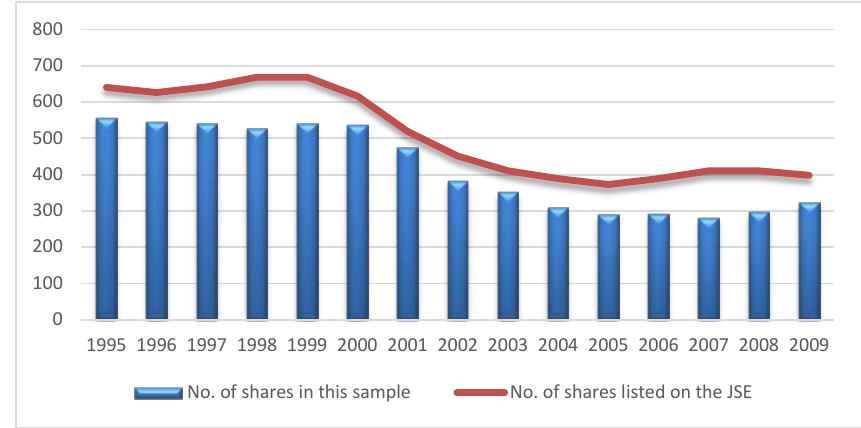
FIGURE 1 : JSE Listings and the Number of Shares in this Sample